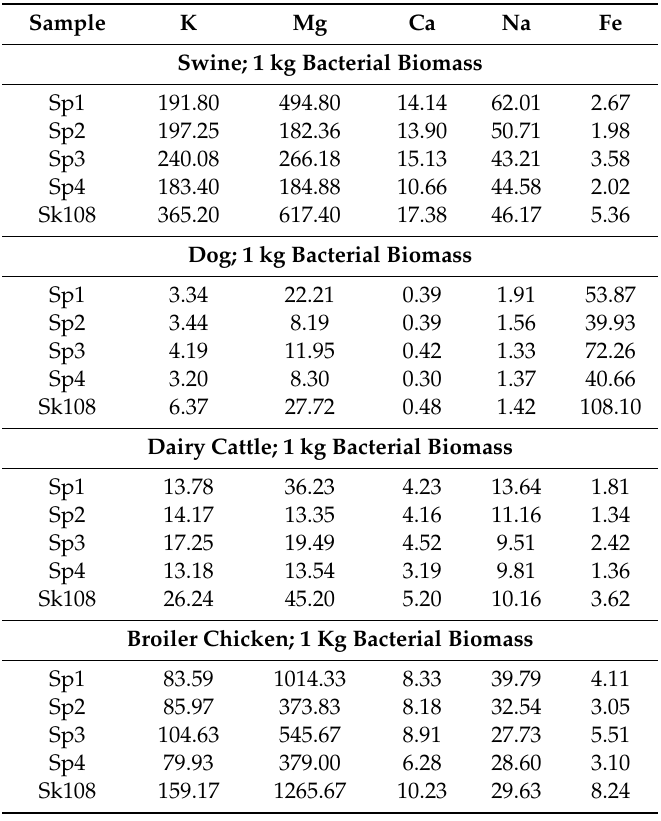
Table 5. Estimated daily supplementation [%] of macronutrients for selected animals with the use of methanotrophic bacterial biomass originating from di ff erent consortia. Each value is calculated for 1 kg of bacterial biomass (according to references